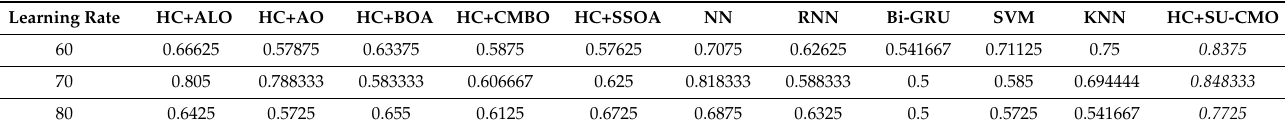
Table 2. Accuracy Analysis of the proposed model over other methods for dataset 1.